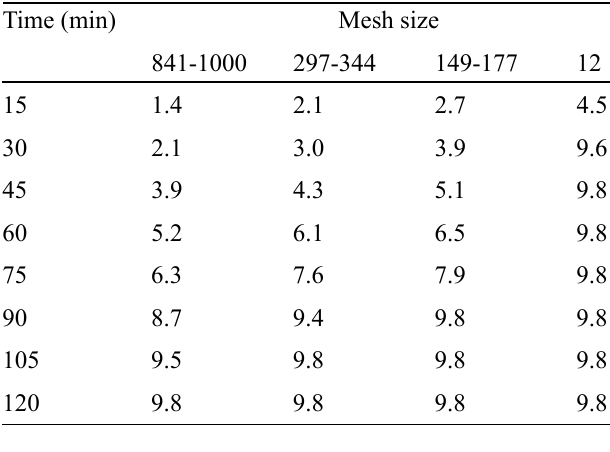
Table 2. Topiramate solubility (mg/ml) variation with time for different particle sizes in water at 25